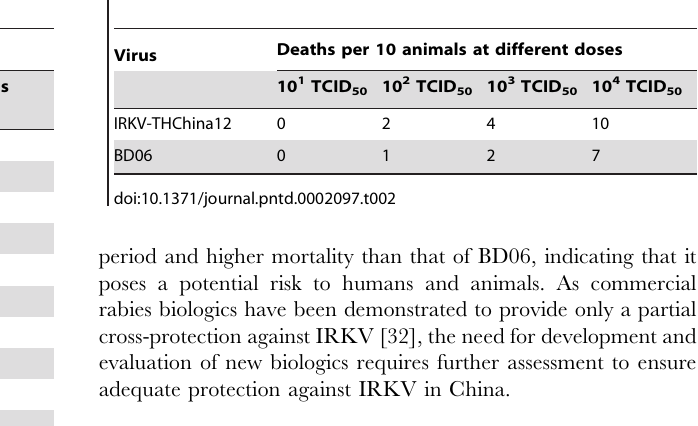
Figure S1 Tonghua county and surrounding regions in Russia and China. Black dots indicate the location of IRKV isolates and/ or IRKV-associated human rabies cases within China and Russia. The red dot identifies where IRKV-THChina12 virus was isolated. Table S1 Primers used for amplification and sequencing of the IRKV-THChina12 genome. Table S2 Lyssavirus sequences used in the present study. (DOC)